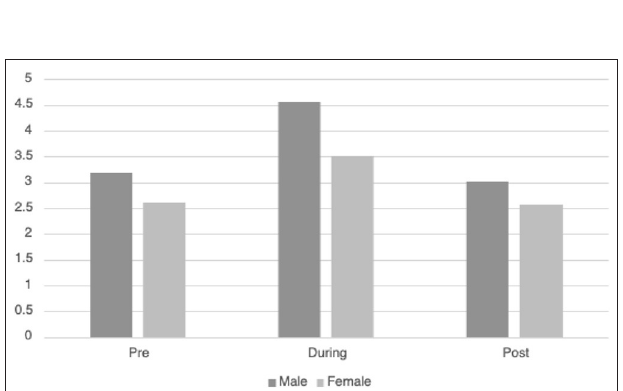
FIGURE 2 | Differences in HRVi Minimum by sex. Males had a higher HRVi Minimum at every time point compared to females ( F (2, 93) = 34.011, p = 0.015, η 2 p =